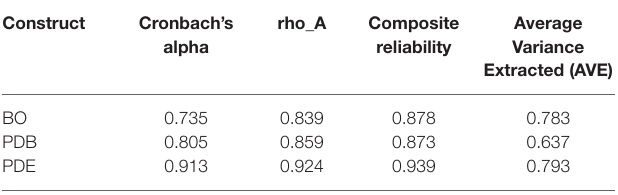
TABLE 2 | Reliability analysis and measurement model estimates. Construct